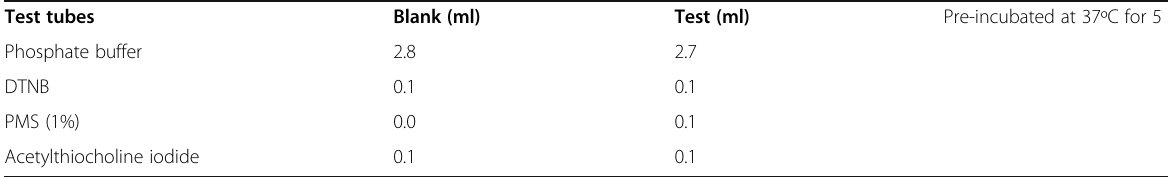
Table 1 Estimation of Brain Acetylcholinesterase (AChE) Activity Test tubes